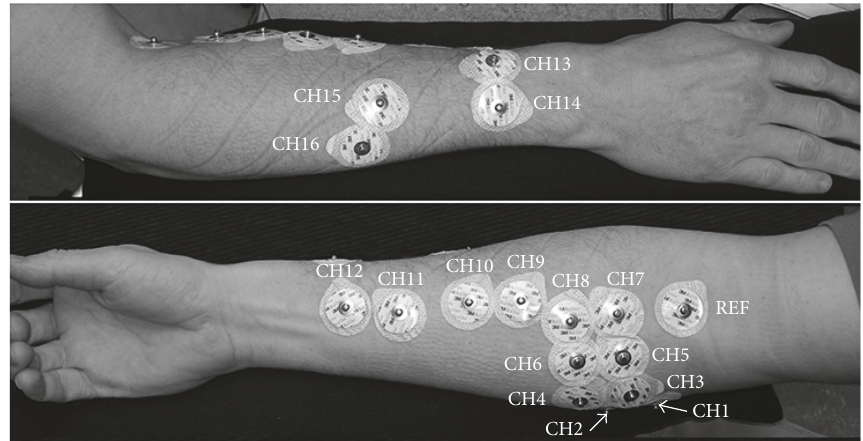
Figure 1: Measurement setup as in [25]. 16 monopolar channels were positioned in accordance with underlying hand muscles. The set of targeted muscles was chosen based on hand movements performed during the measurement protocol.